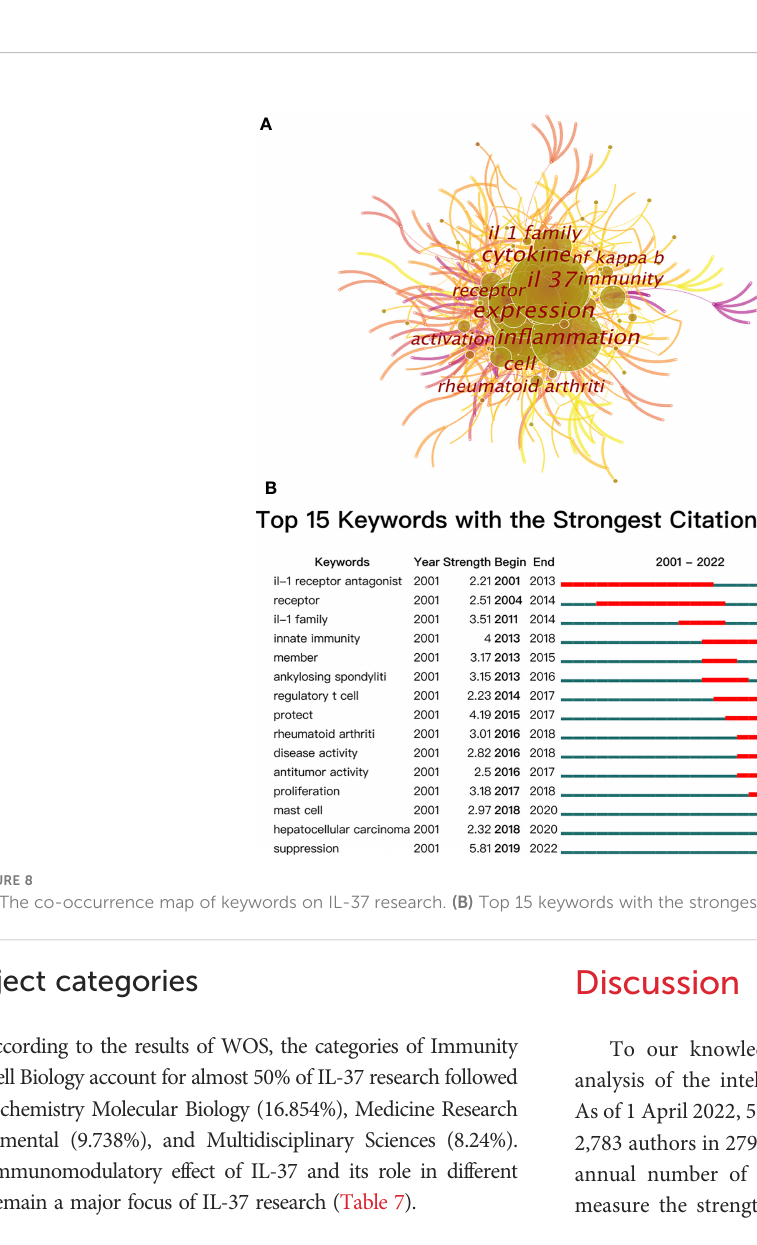
TABLE 6 The top 20 keywords of IL-37